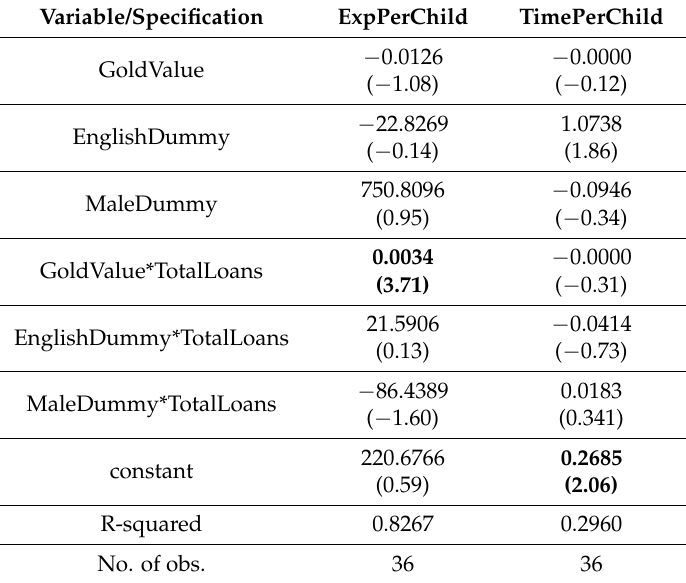
Table 6. Educational Investment: Wealth, Gender and Social